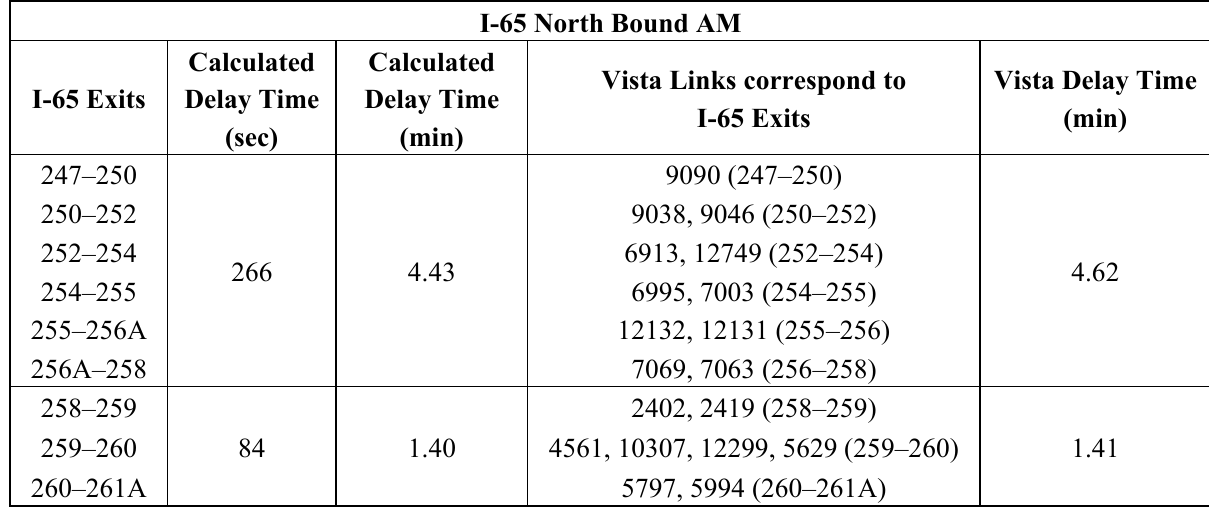
Table 3. Sample Delay Time Comparisons for Model